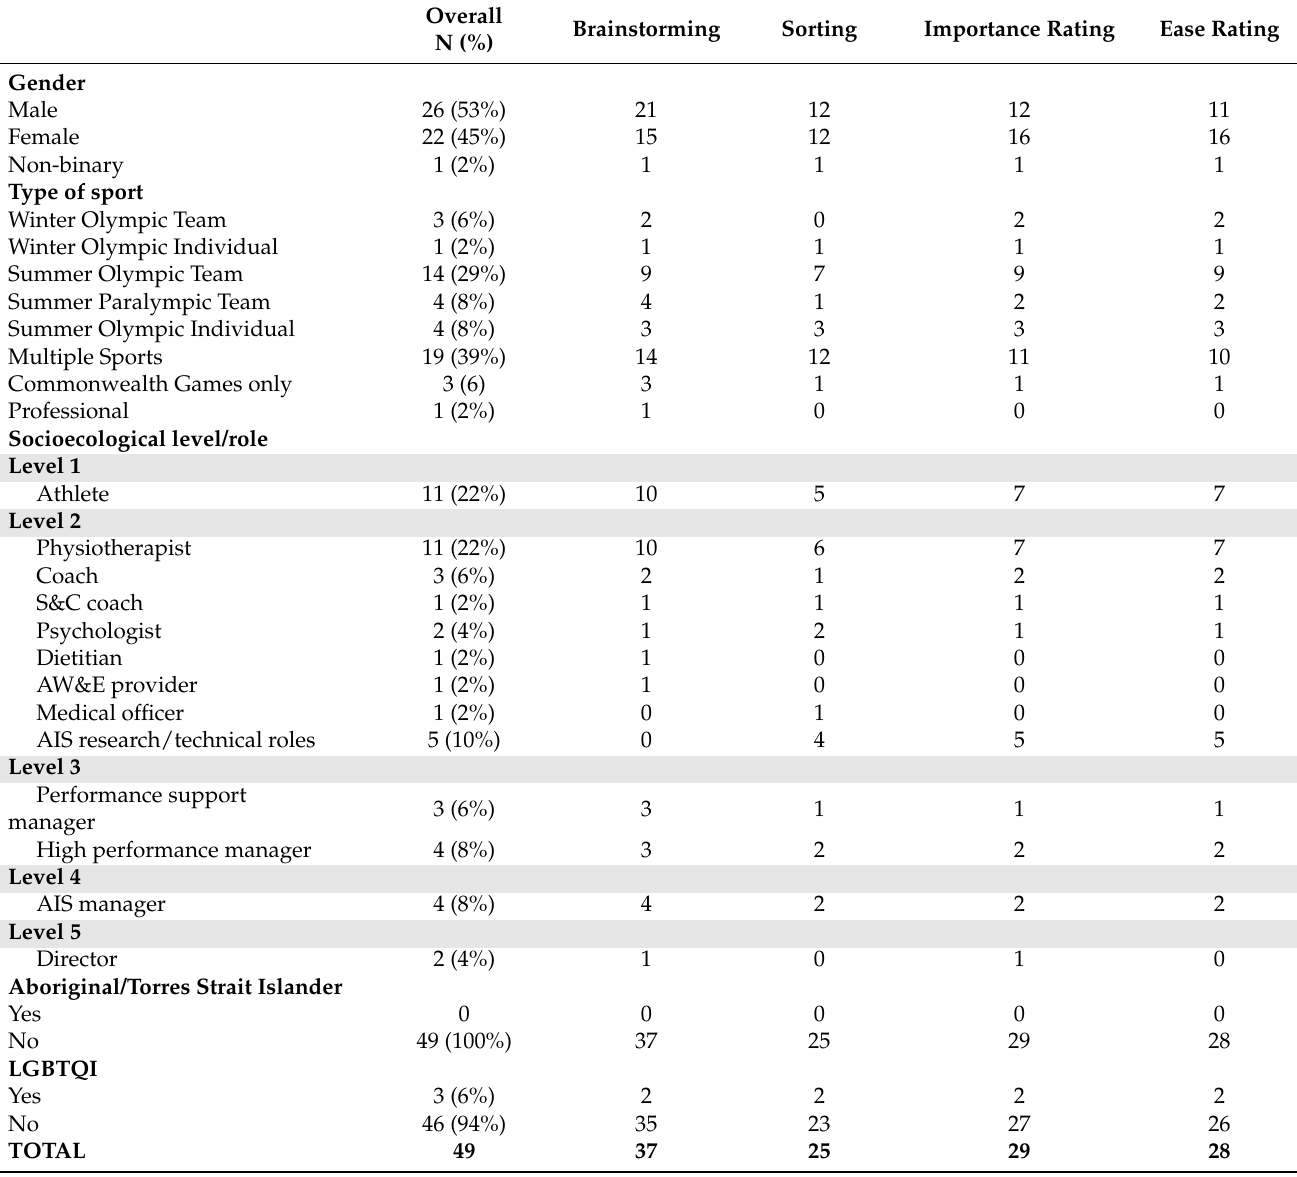
Table 1. Participant demographic summary and socioecological level and role for each CM